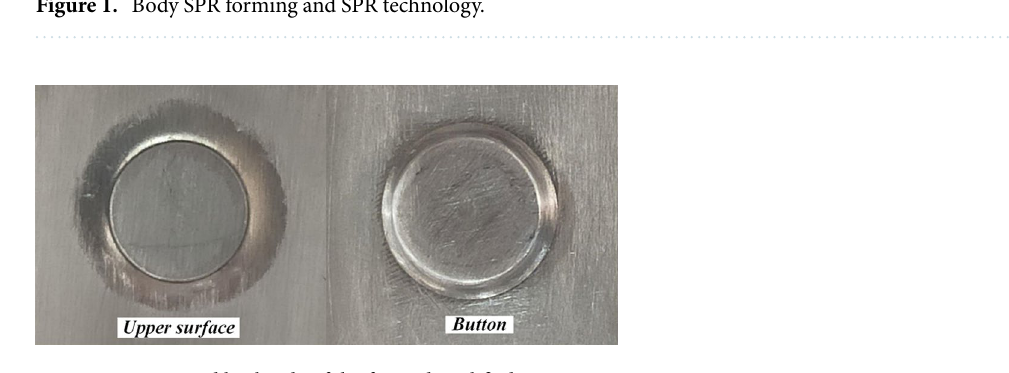
Figure 2. Front and back side of the formed qualified